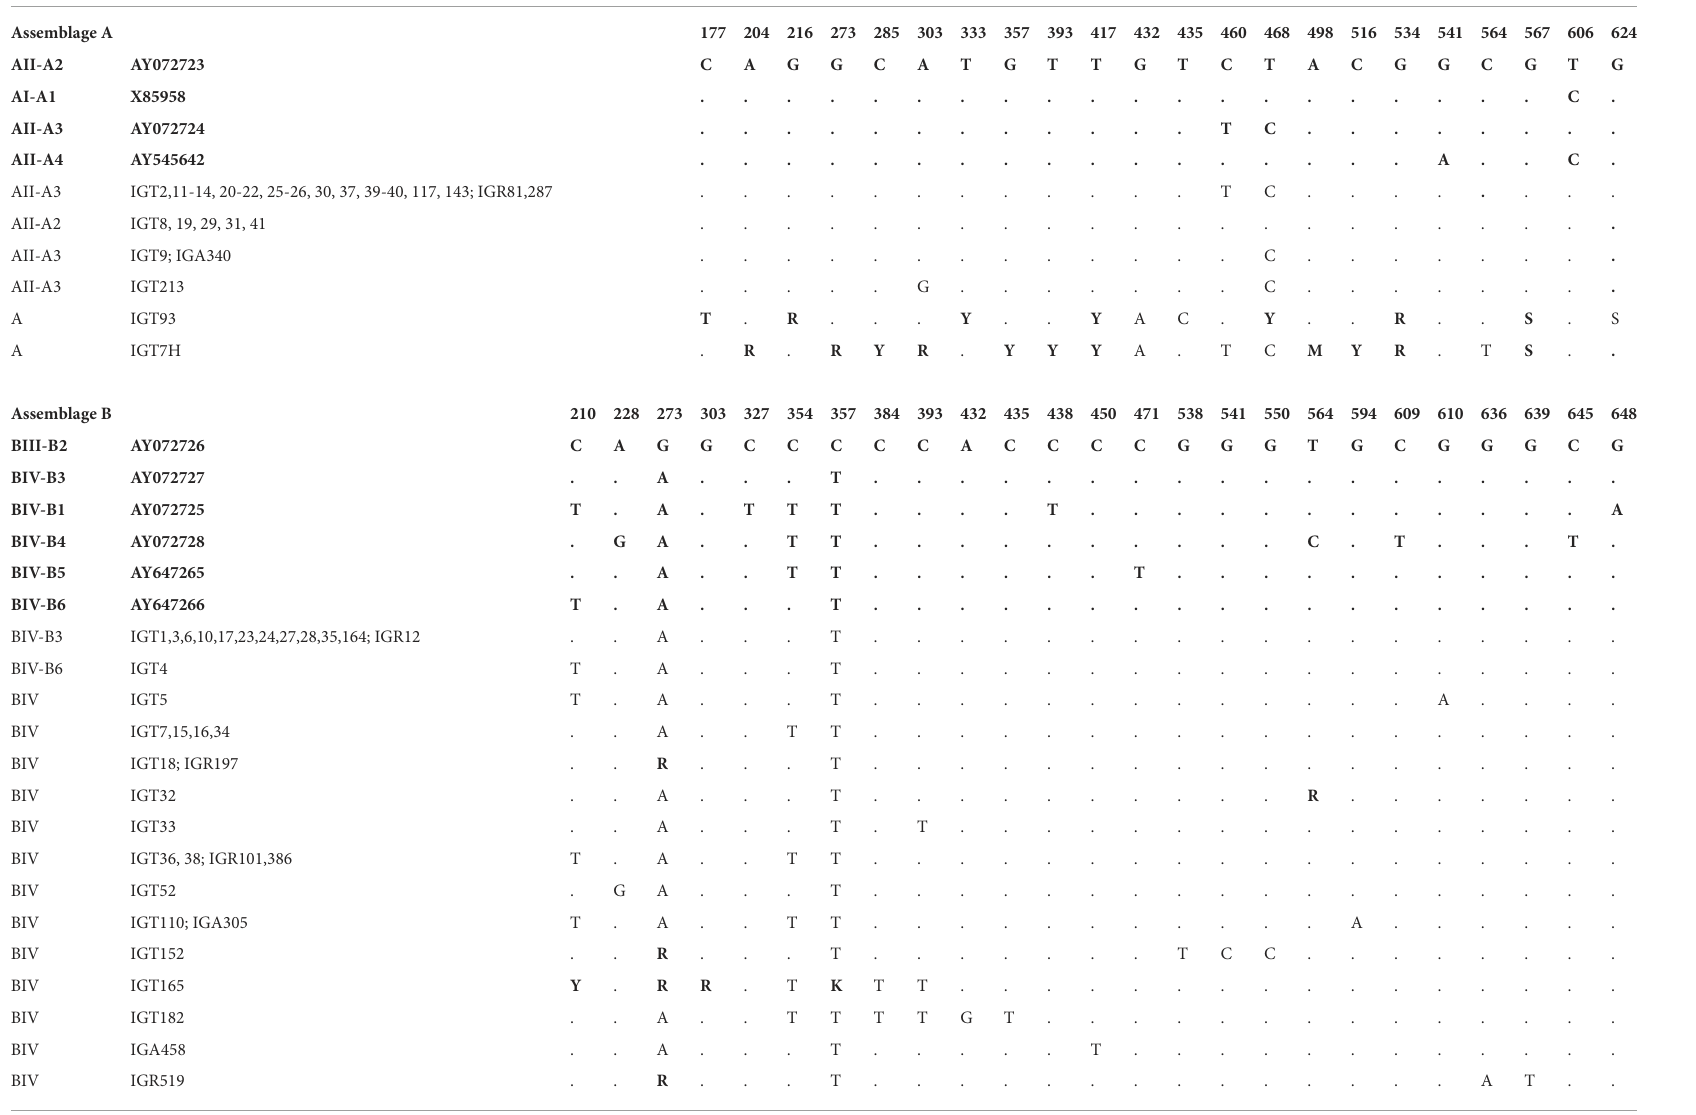
TABLE 5 β -giardin ( bg ) multiple alignment sequence isolates in this study with reference sequences retrieved from GenBank, representing position of intra-genotypic substitutions in sub-assemblages of assemblages A and B. Isolates/GenBank accession no. Nucleotide position from the start of the gene Assemblage